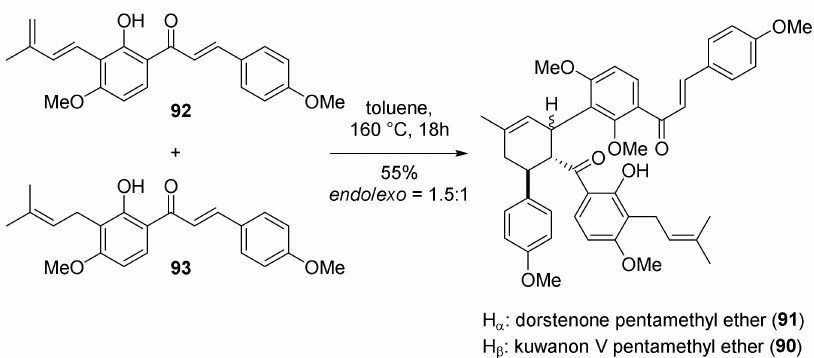
Figure 30. Synthesis of kuwanon V and dorsterone pentamethyl ethers ( 90 and 91